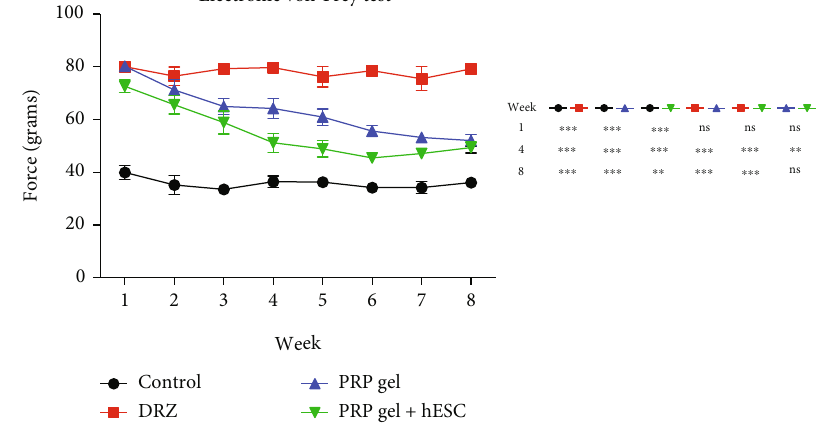
Figure 3: Electronic Von Frey measurements (mean values) obtained from the right hind paw (lesioned). The values are shown as the grams applied to trigger the “ fl inch ” response. Statistical di ff erences among groups are indicated with asterisks in addition to the graph. ∗ p < 0 : 05 ; ∗∗ p < 0 : 01 ; ∗∗∗ p < 0 : 001 . Only the groups that underwent root repair with the PRP gel demonstrated the recovery of sensitivity to tactile stimulation. Further, the PRP gel + hESC group had the best performance in the whole